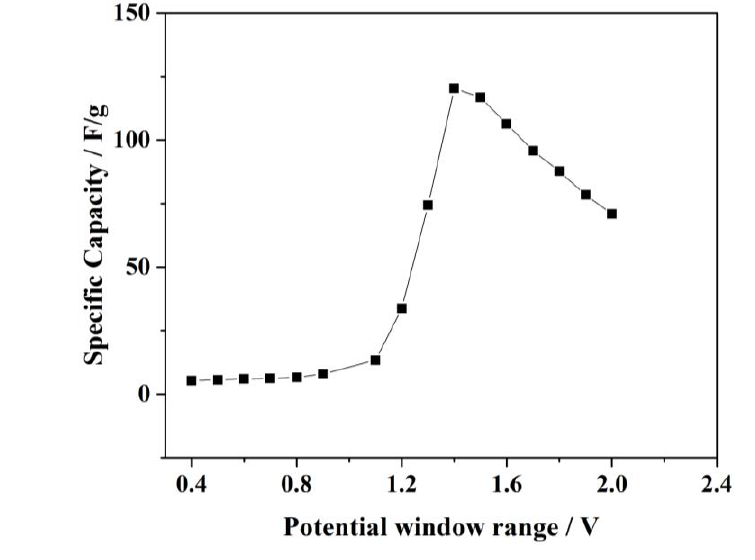
Figure 6: Variation of specific capacity with potential window of